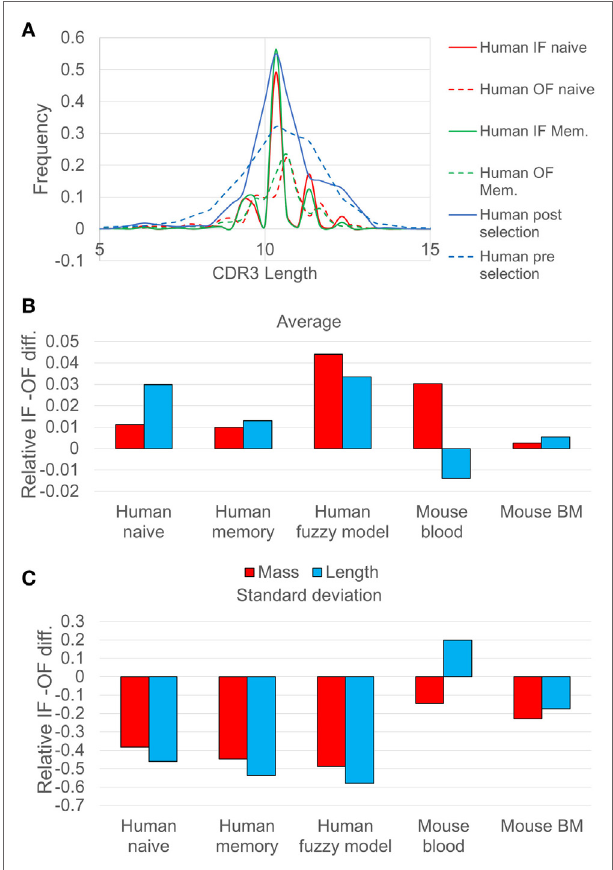
FigUre 1 | (a) Comparison of CDR3 length distribution in human in-frame (IF) and out-of-frame (OF) sequences. The continuous lines represent the IF reads, while the dashed lines represent the OF reads. Pre-selection (IF) and post selection (OF) curves (blue) correspond to human naive sequences analyzed using the probabilistic model, whereas the red curves correspond to the same human naive sequences analyzed using the deterministic model. The CDR3 length distribution is narrower after selection, indicating selection against too long or too short sequences. (B) The relative difference between the SD of CDR3 length/mass between IF sequences and OF sequences (the ratio minus 1), for different samples of human and mice. The blue bars represent the CDR3 length ratio, and the red bars represent the calculation of CDR3 mass ratio (the p values of the F -test are less than 0.001 except from the mouse blood sample which are less than 0.01). (c) The same for the average over length/mass of the CDR3, for different samples of human and mice (the p values of the T -test are less than 0.001 except from the mouse BM and the mouse blood which are less than